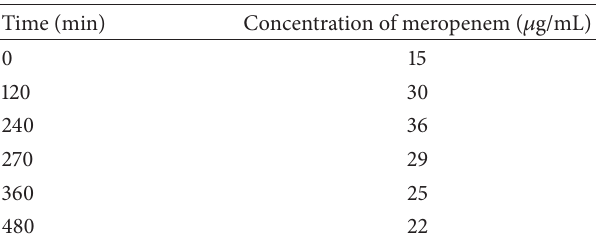
Table2:Serummeropenemconcentrationsgivenasa4 hprolonged infusion of 40 mg/kg, every 8